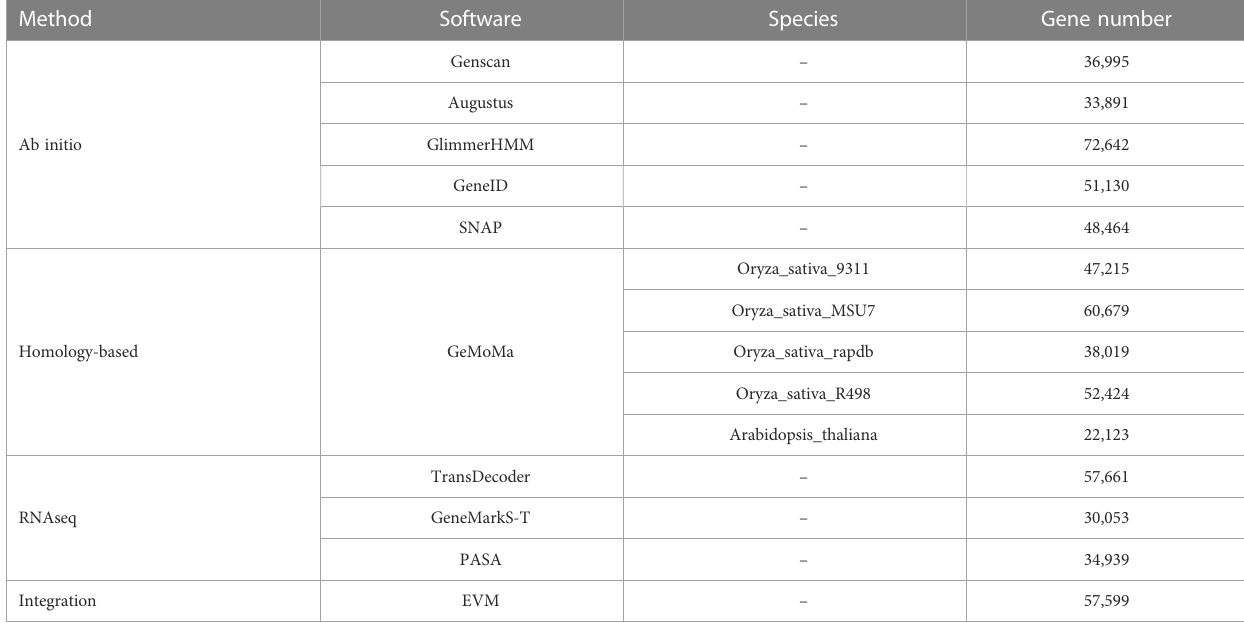
combinations of Hd1 , DTH7 , and Ghd7 determined the early heading in QG10 in the northernmost province of China.